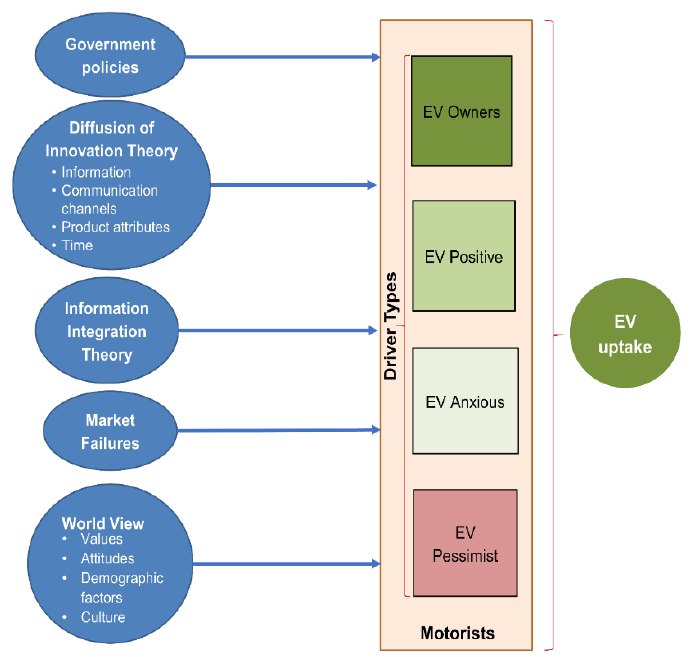
Figure 1. Conceptual framework: the rate at which motorists buy EVs is affected by multiple factors, including consumers’ world views [22], integration of information [39], the processes associated with diffusion of innovation [27] (Section 2) and the influence of government policies and market failures [38]. Motorists were segmented into Driver Types dependent on their attitudes to EVs, and this research focused on four principal